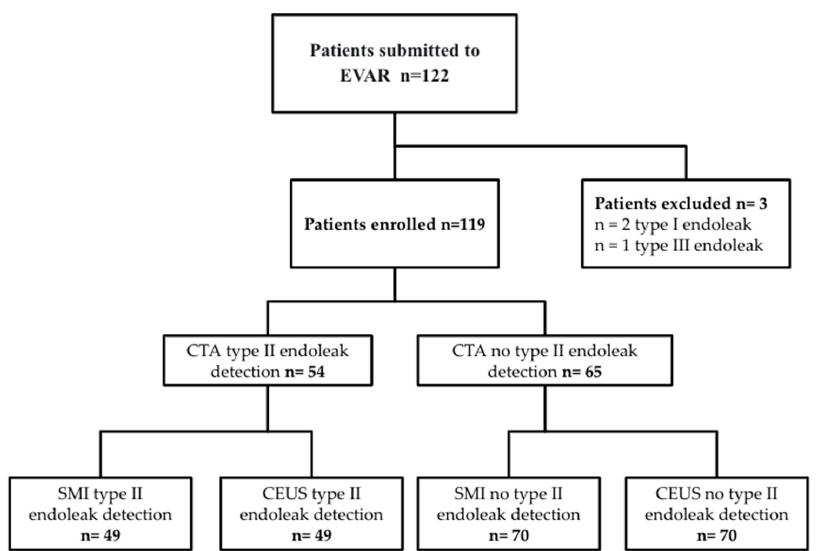
Figure 1. Flowchart of all EVAR (2017–2020) included in the study and endoleaks detected with SMI, CEUS, and CTA.